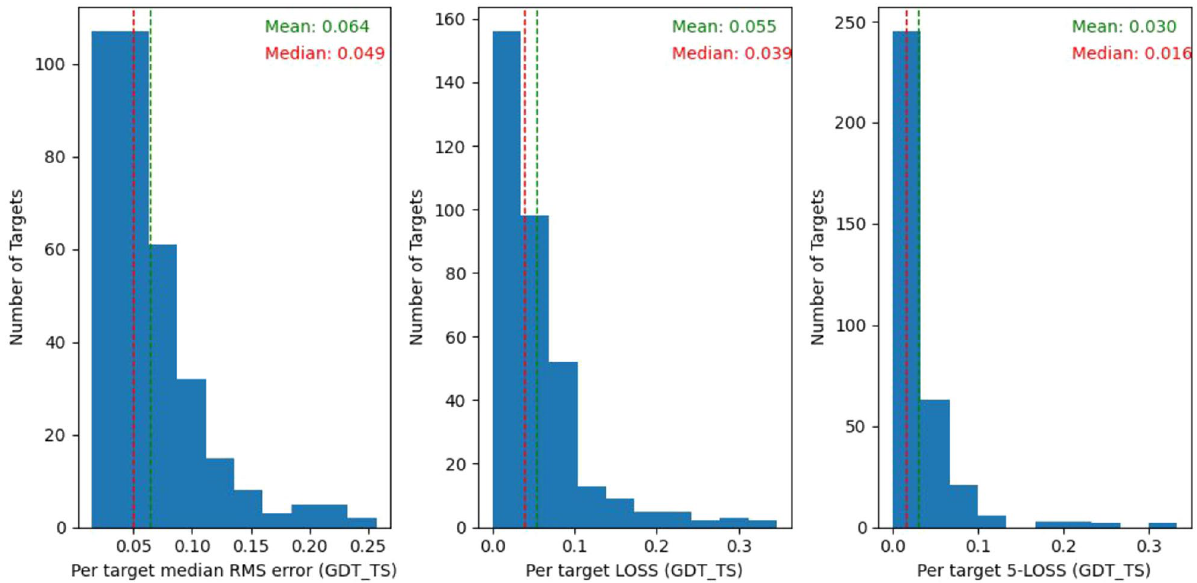
Figure 4. Benchmark performance of MESHI_consensus. The results of 345 leave-one-target-out experiments are summarized in three histograms: (A) RMSE; (B) LOSS, the difference between the quality of the top-ranking model and the quality of the best one. (C) LOSS5, the minimal difference between the qualities of 5 top-ranking models and the quality of the best one. Median (red) and mean (green) values are indicated by vertical lines.